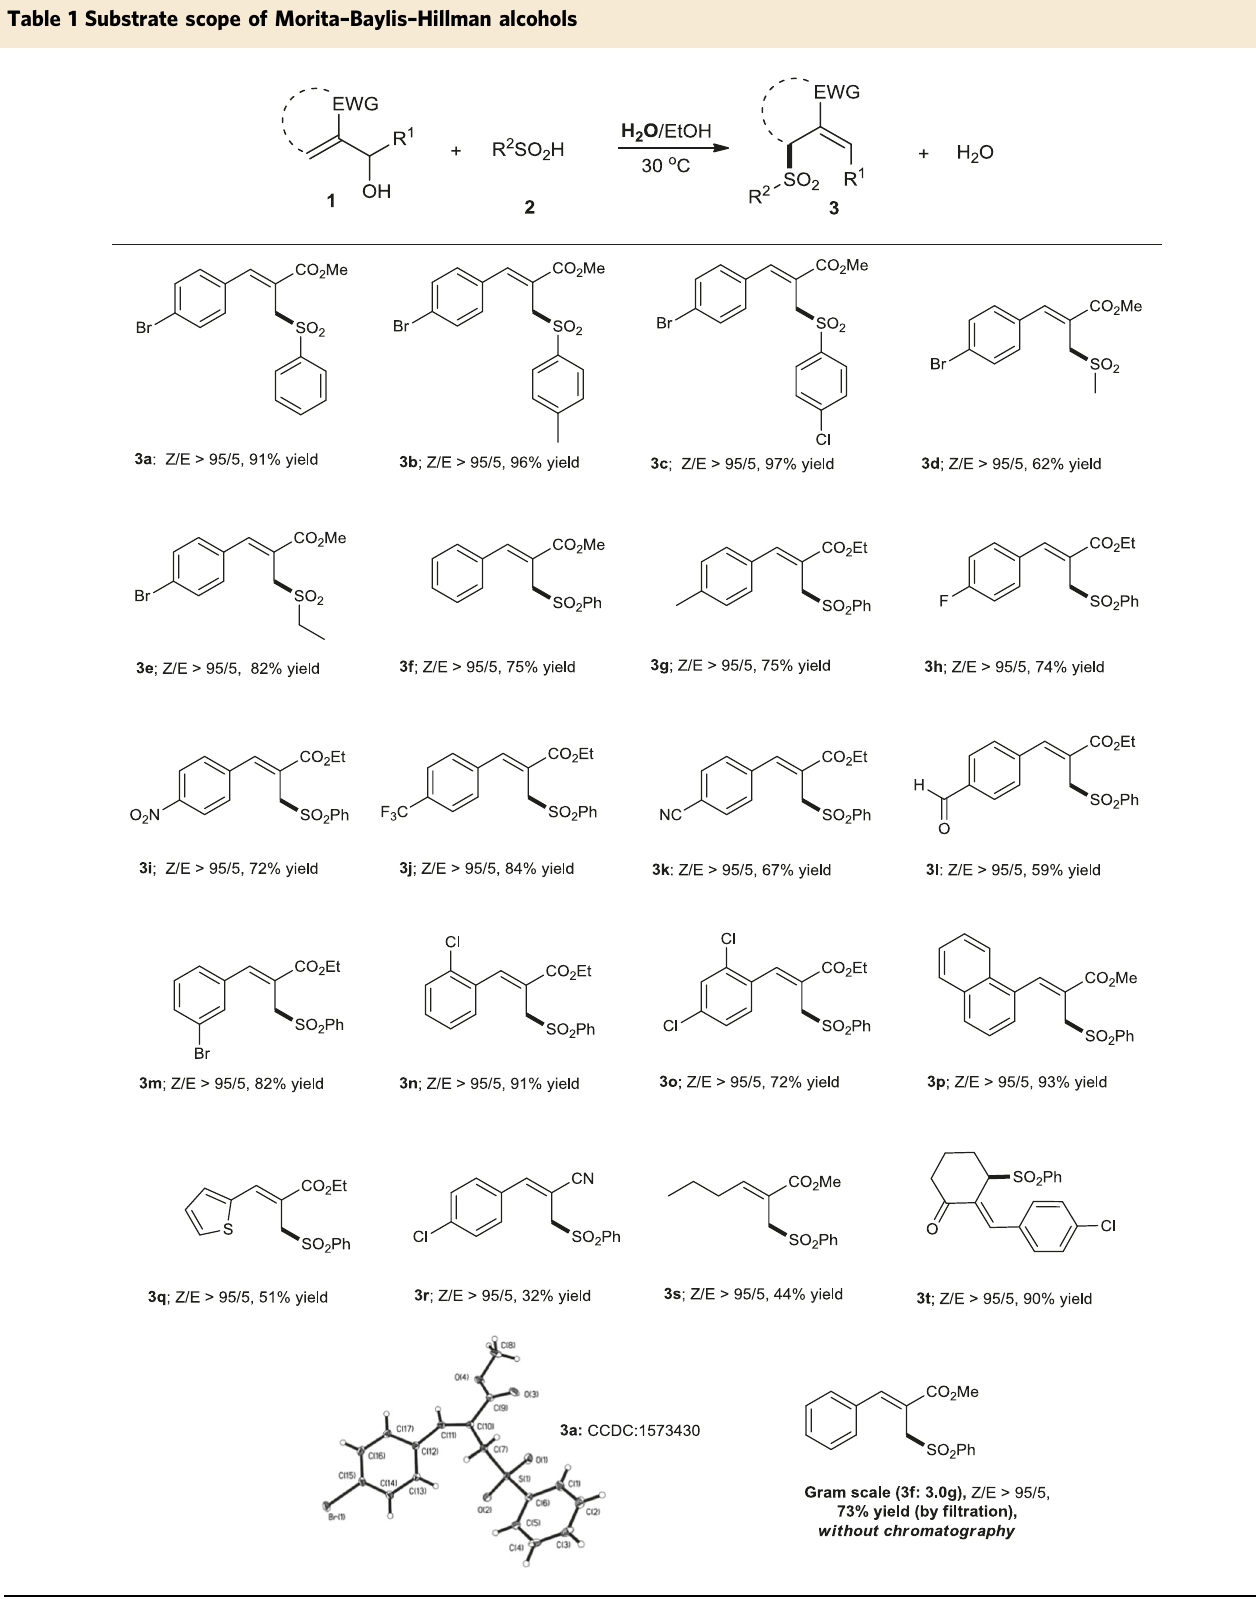
Table 1 Substrate scope of Morita – Baylis – Hillman